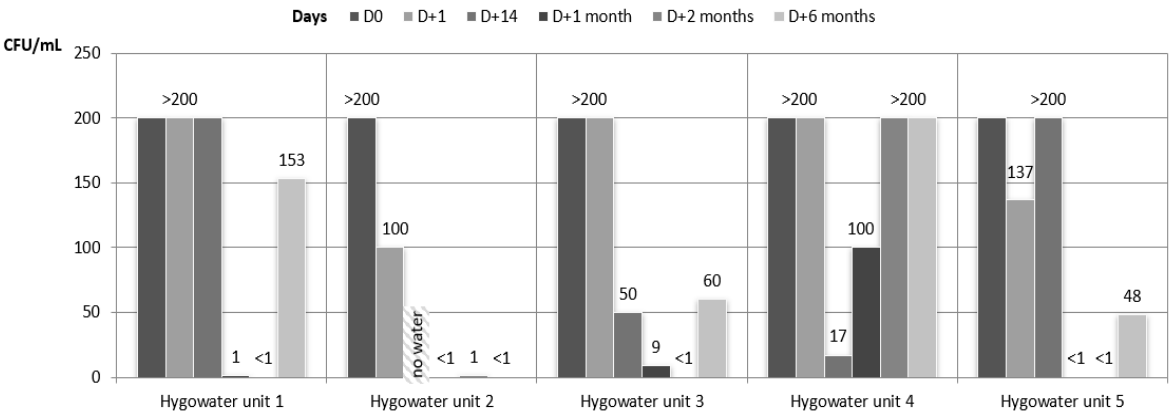
Figure 2. Microbiological quality of the water samples for the units connected to the Hygowater ® system. HPC at 37 °C.